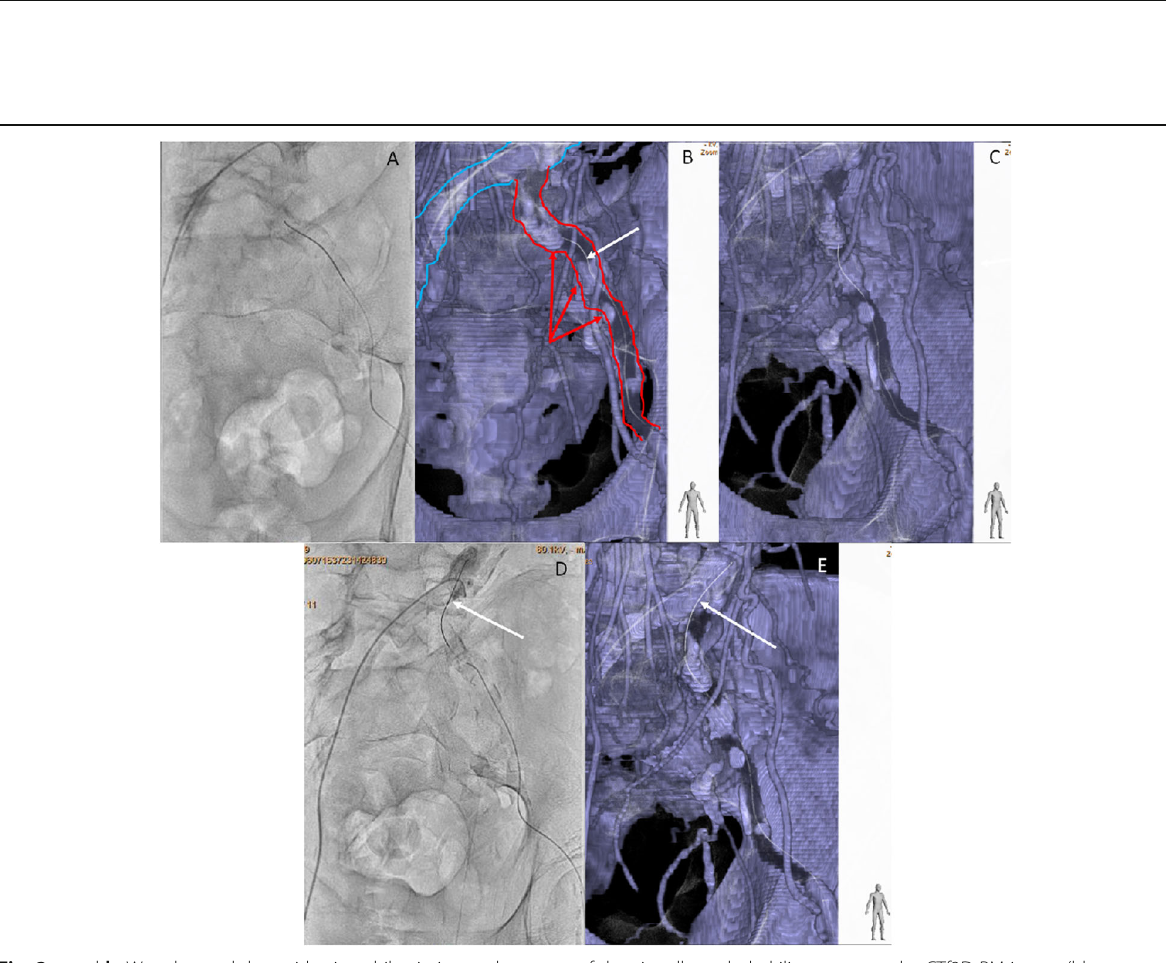
Fig. 3 a and b : We advanced the guidewire while aiming at the center of the virtually occluded iliac artery on the CTf3D-RM image (blue arrow showed opened aorta and right CIA, red arrow showed virtual occluded vessels, white arrow showed guidewire). c : We checked the wire position in RAO view. The guide wire was almost centor in the virtual occluded iliac artery. d and e : We could pass the guidewire retrogradely into the